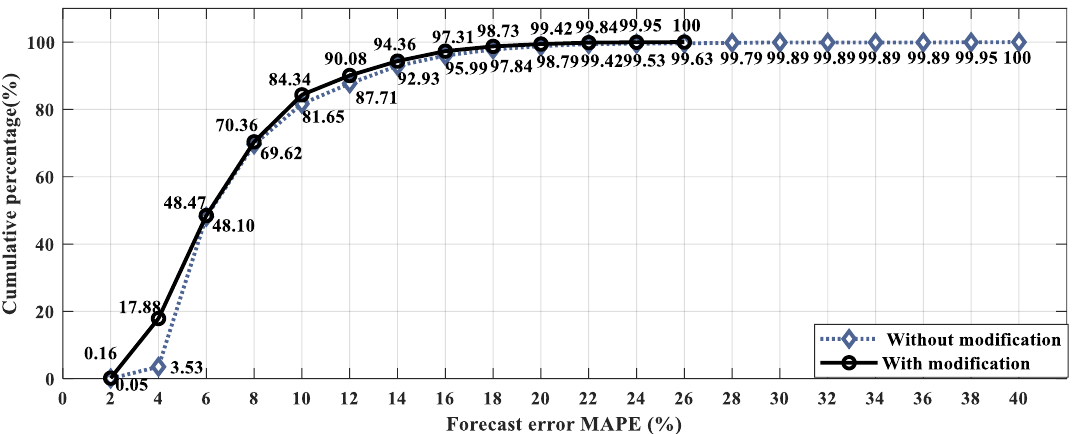
Figure 5. Mean absolute percentage error (MAPE) cumulative distribution with and without modification.